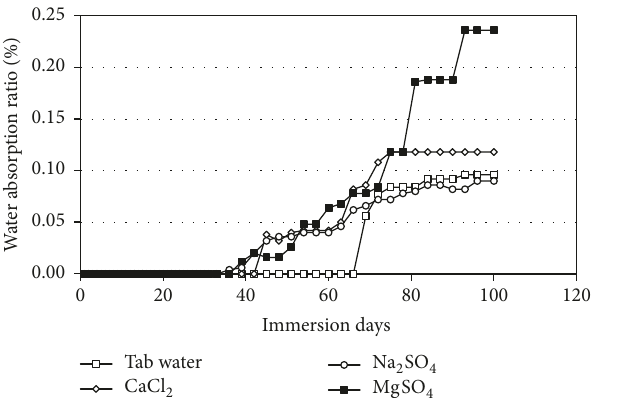
Figure 10: Absorption test results of hybrid panels.